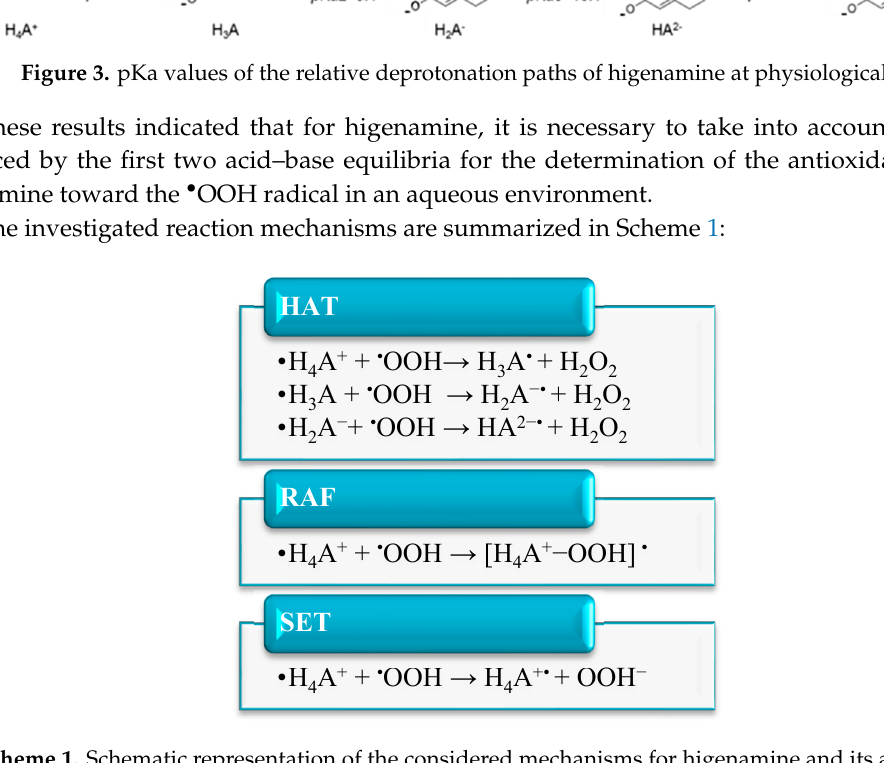
Figure 3. pKa values of the relative deprotonation paths of higenamine at physiological pH.